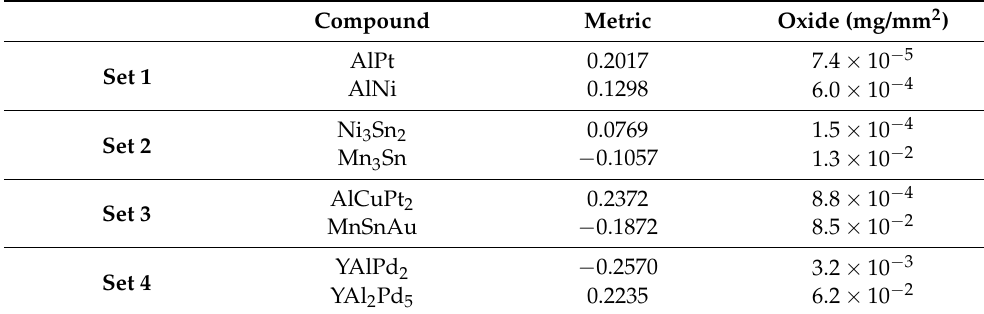
Table 1. Compositions, oxidation metric, and experimentally measured oxidation quantity (see Section 2), for different matched